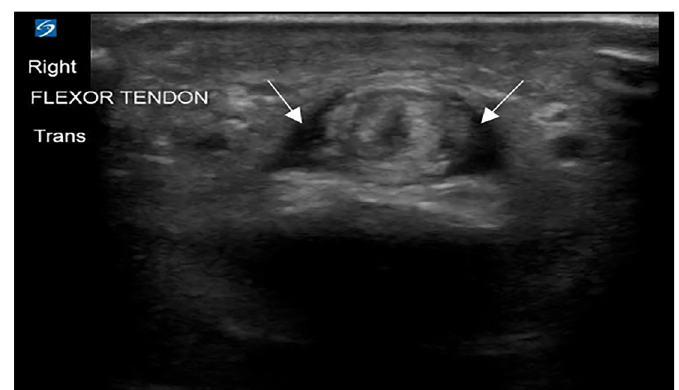
Image 2. Transverse ultrasound view of the right middle finger. The image displays anechoic fluid (white arrows) surrounding the flexor tendon within the tendon